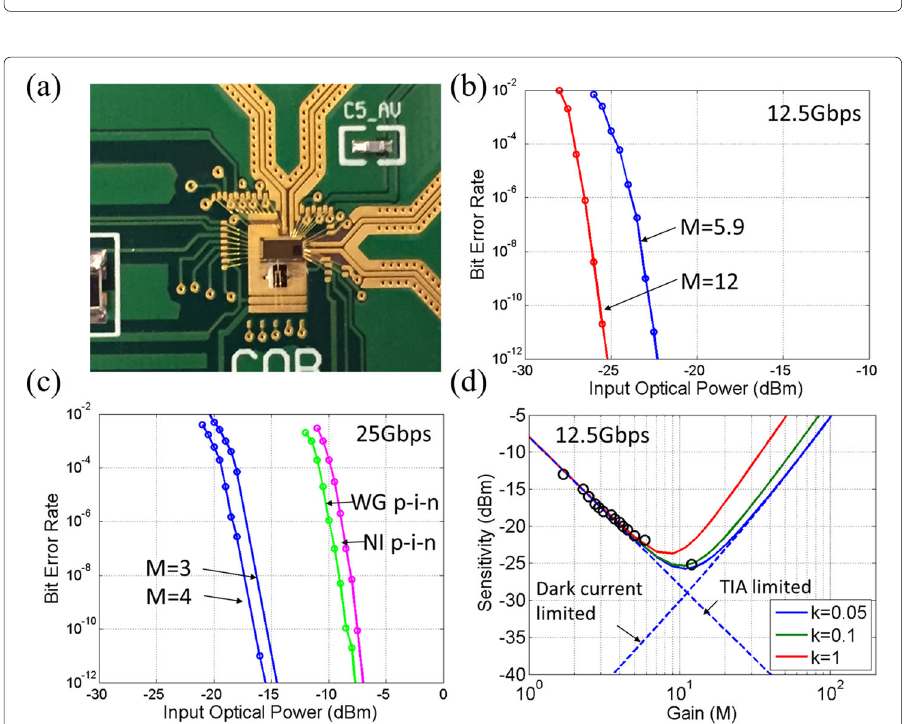
Fig. 13 a Prototype of the APD CMOS receiver; Measured BER curves at b 12.5 Gb/s and c 25 Gb/s; d Receiver sensitivity analysis at 12.5 Gb/s